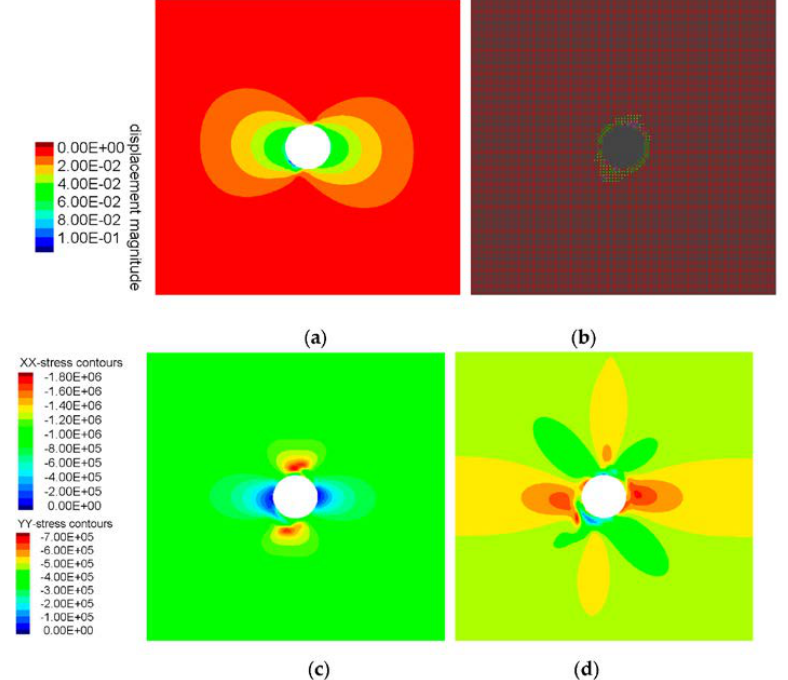
Figure 22. Simulation results for tunnel model with joint orientation of − 60° and κ = 0.5: ( a ) displacement contours [m], ( b ) plasticity state, ( c ) contour plot of horizontal stresses [Pa] and ( d ) contour plot of vertical stresses [Pa].